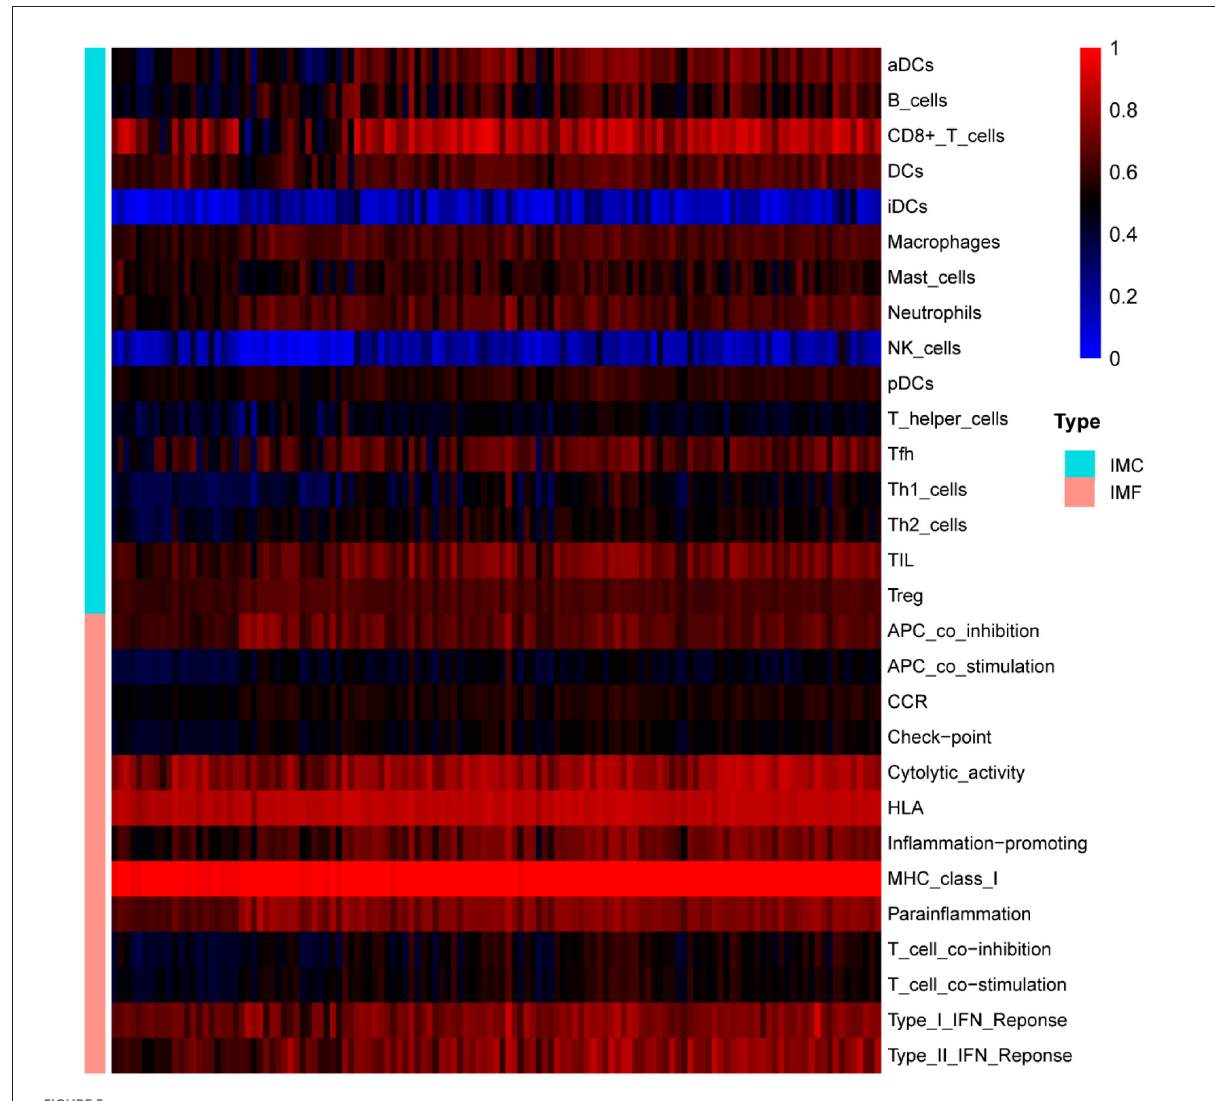
FIGURE5 The overall landscape of immune infiltration in UC. Each row represents one sample, either healthy or UC, each column represents a type of immune cell or immune function. IMC, immune cell; IMF, immune